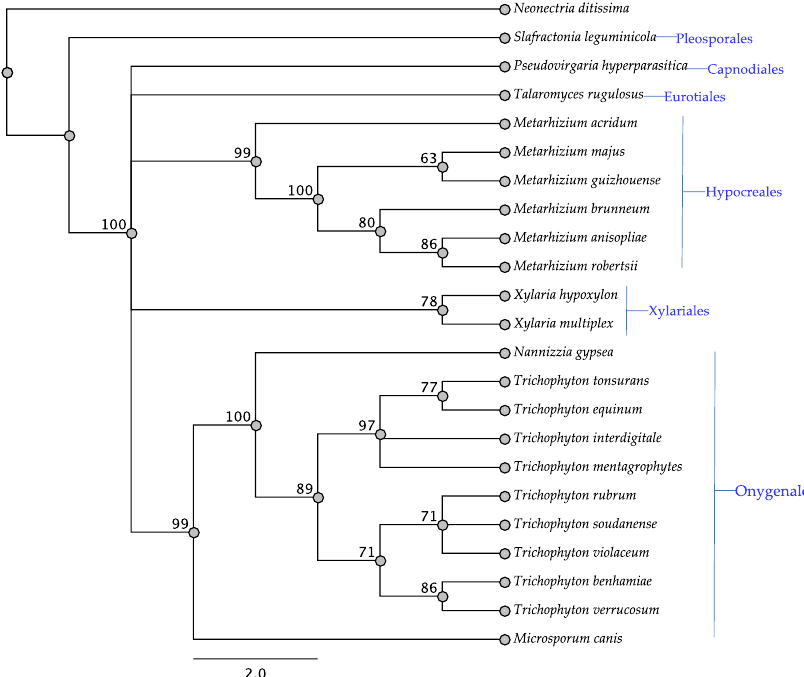
Figure 7. Maximum parsimony protein tree resulting from the analysis of SwnT. Bootstrap confidence values from 1000 bootstrap replicates are presented at each corresponding node. Neonectria ditissima (Hypocreales) was used as the outgroup and obtained from NCBI database, GenBank accession: KPM36795.1. Fungal orders are indicated next to each organism/clade.